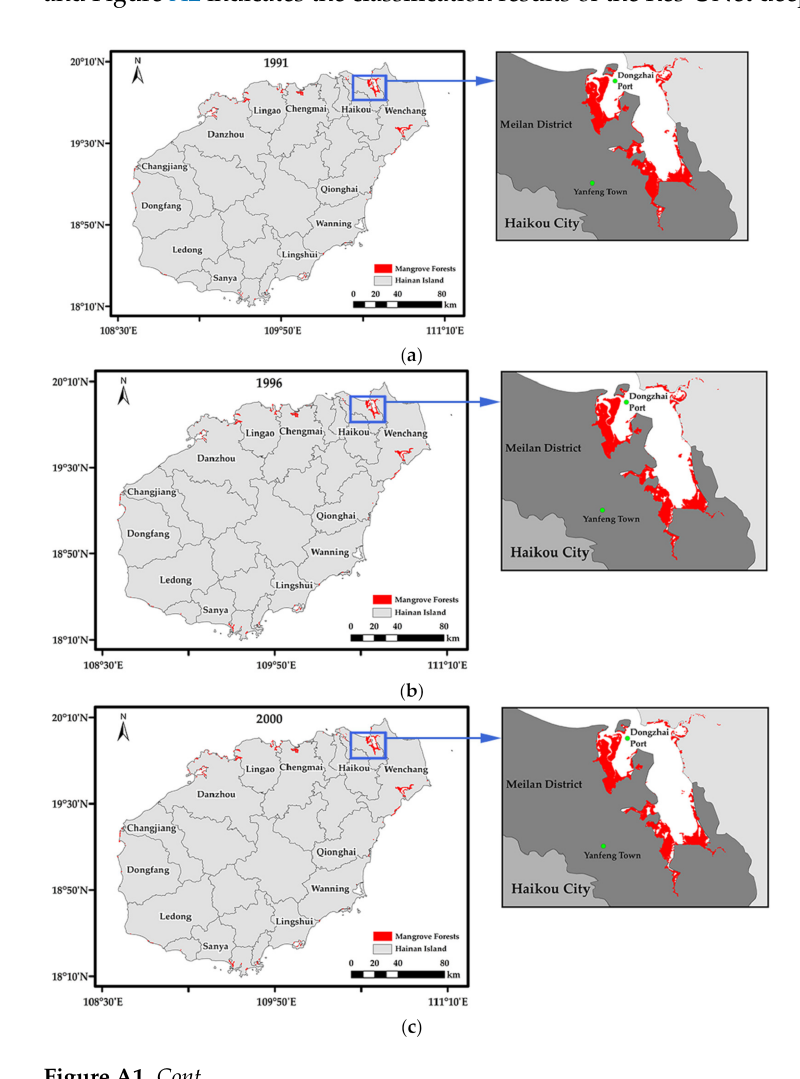
Figure A1 indicates the classification results of the SVM machine-learning algorithm, and Figure A2 indicates the classification results of the Res-UNet deep learning algorithm.